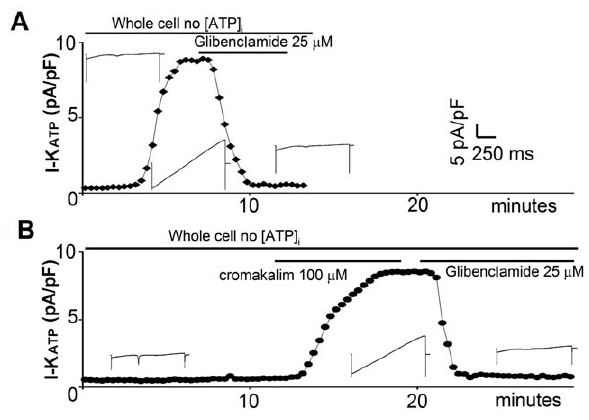
Figure 1. I ATP obtained by dialysis of intracellular ATP is missing in the mdx cardiac cells. Time course of I ATP development in wt (A) and mdx cultured cardiomyocytes (B). In wt cells the dialysis of ATP rapidly induces the I ATP current that is selectively abolished by the application of the antagonist. In the mdx cells no I ATP is induced by the whole-cell recording conditions after 13 minutes. The current develops show the current traces relative to the time point.